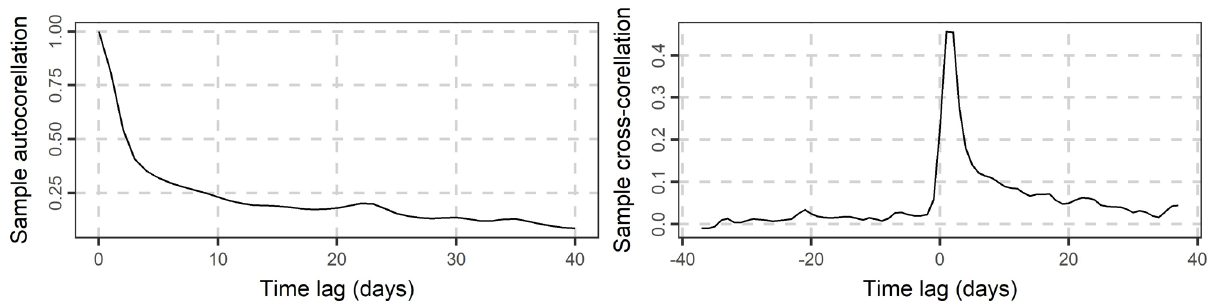
Figure 2. Sample autocorrelation of the daily streamflow of the Current river and sample cross-correlation with the daily precipitation of the basin. The sample cross-correlation is the estimate of Corr[ x i , y i + j ], where Corr is the cross-correlation